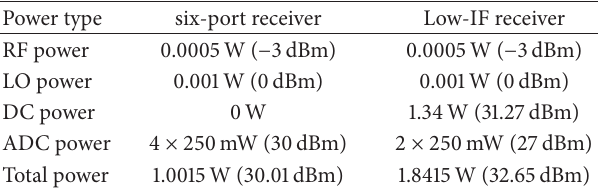
Table 4: Power requirements of different receivers under test. Table 5: Port matching of different receivers under